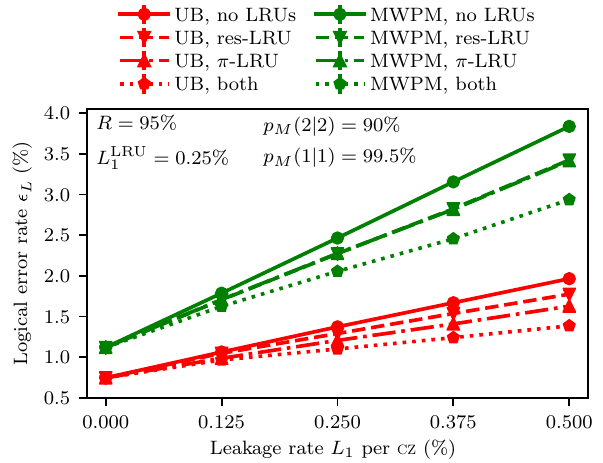
FIG. 5. Logical error rate ε L per QEC cycle for the upper bound (red) and minimum-weight perfect-matching (green) decoders versus the CZ leakage rate L 1 , in the cases with no LRUs, only res-LRU, only π -LRU, and both LRUs (the point without leakage at L 1 = 0 is always without LRUs as well). These results are extracted from 2 × 10 4 runs of 20 QEC cycles each per choice of parameters. Error bars are estimated using bootstrapping and are smaller than the symbol